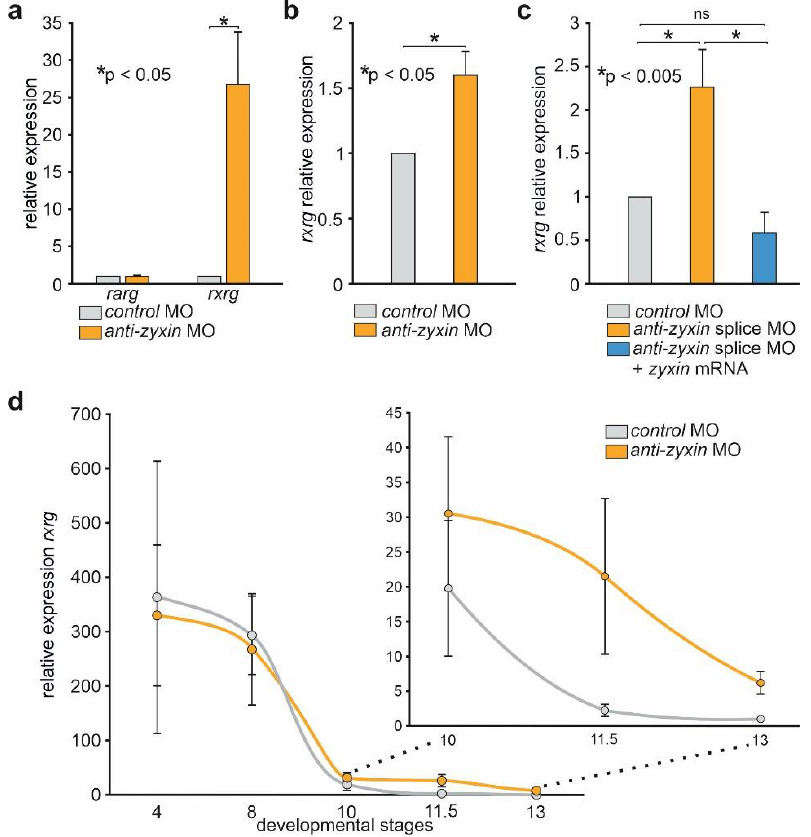
Figure 1. Downregulation of Zyxin results in an increase in the rxrγ mRNA level in the Xenopus laevis embryos. ( a ) Analysis by qRT-PCR of rxrγ and rarγ expression in the middle-gastrula stage Xenopus laevis embryos injected with the control and anti-zyxin MO. Here and below the transcript levels of the housekeeping genes odc1 and eef1a1 were used for the data normalization. Error bars indicate standard deviation. ( b ) Analysis by qRT-PCR of rxrγ expression at bud stage of Danio rerio embryos injected with the control and anti- zyxin splice MO. ( c ) Analysis by qRT-PCR of the rescue effect on rxrγ expression of zyxin mRNA. ( d ) Comparative analysis of the rxrγ transcripts levels in Zyxin knocked-down and control embryos at different stages of development. The inset shows at larger scale the data for stages from 10 to 13. The data presented are averaged from at least three independent experiments.